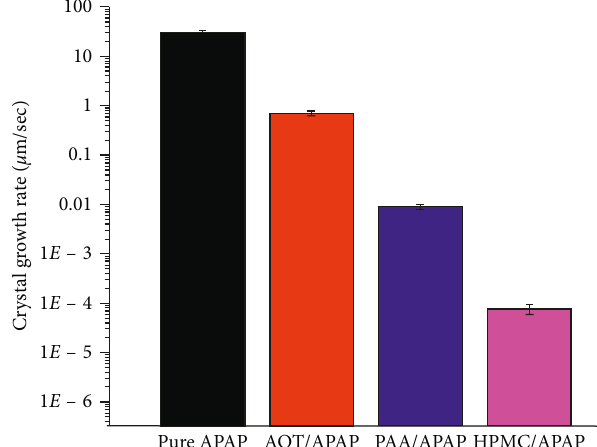
Figure 3: Interfacial crystal growth rate of APAP on citric CS films in the presence of different